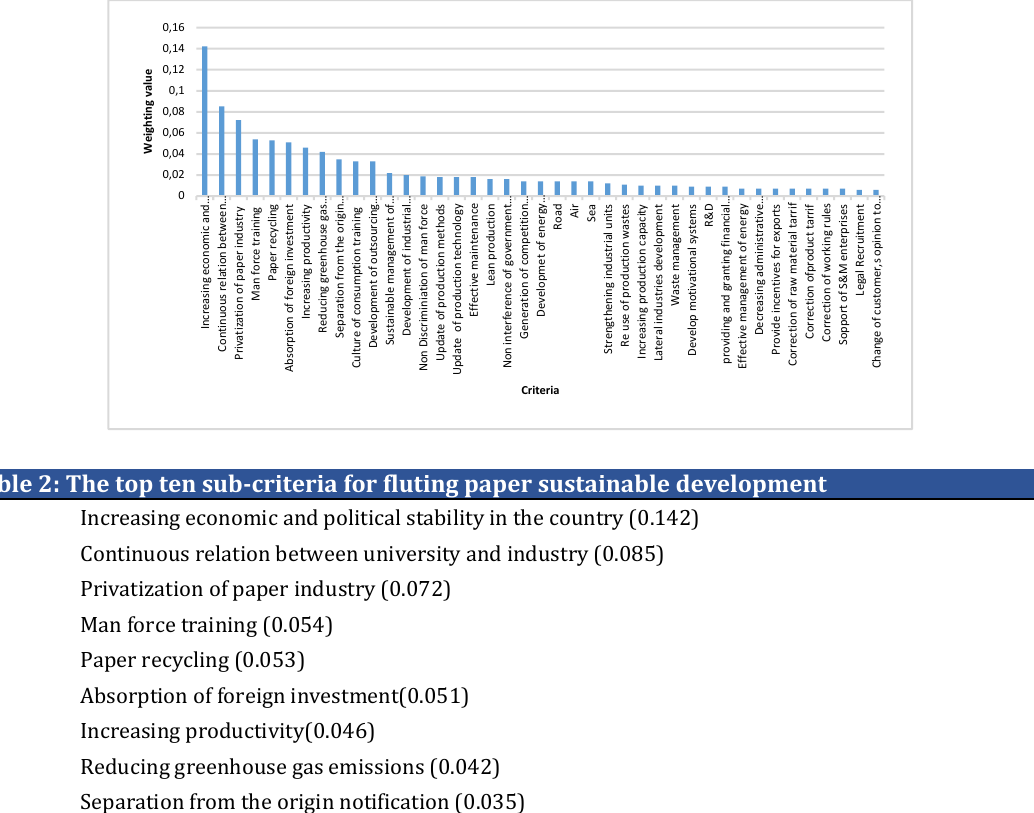
Figure 4: Overall result of weighting value of sub criteria (Inconsistency ratio = 0.08)